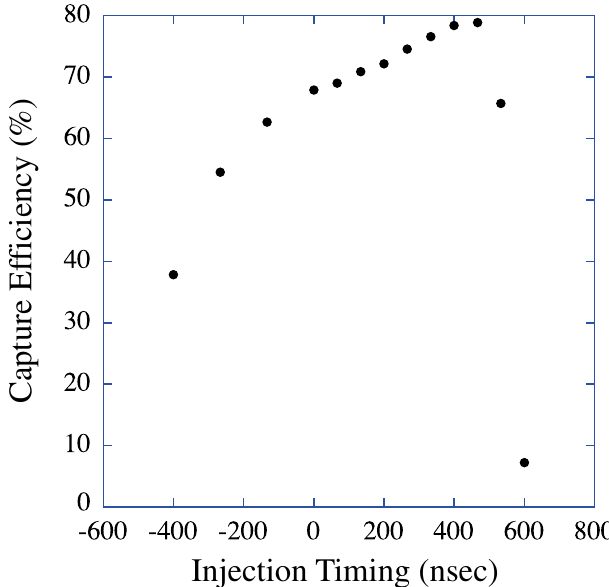
FIG. 11. (Color) Capture efficiency as a function of the injection timing with the injection angle of 1.7 mrad. The ‘‘zero’’ denotes that the injected beam comes at the peak of the PSM’s excitation. The positive value means that the injected beam is delayed compared with the pulse peak. The betatron tune is ð (cid:7) x ; (cid:7) y Þ ¼ ð 9 : 60 ; 5 : 28 Þ .